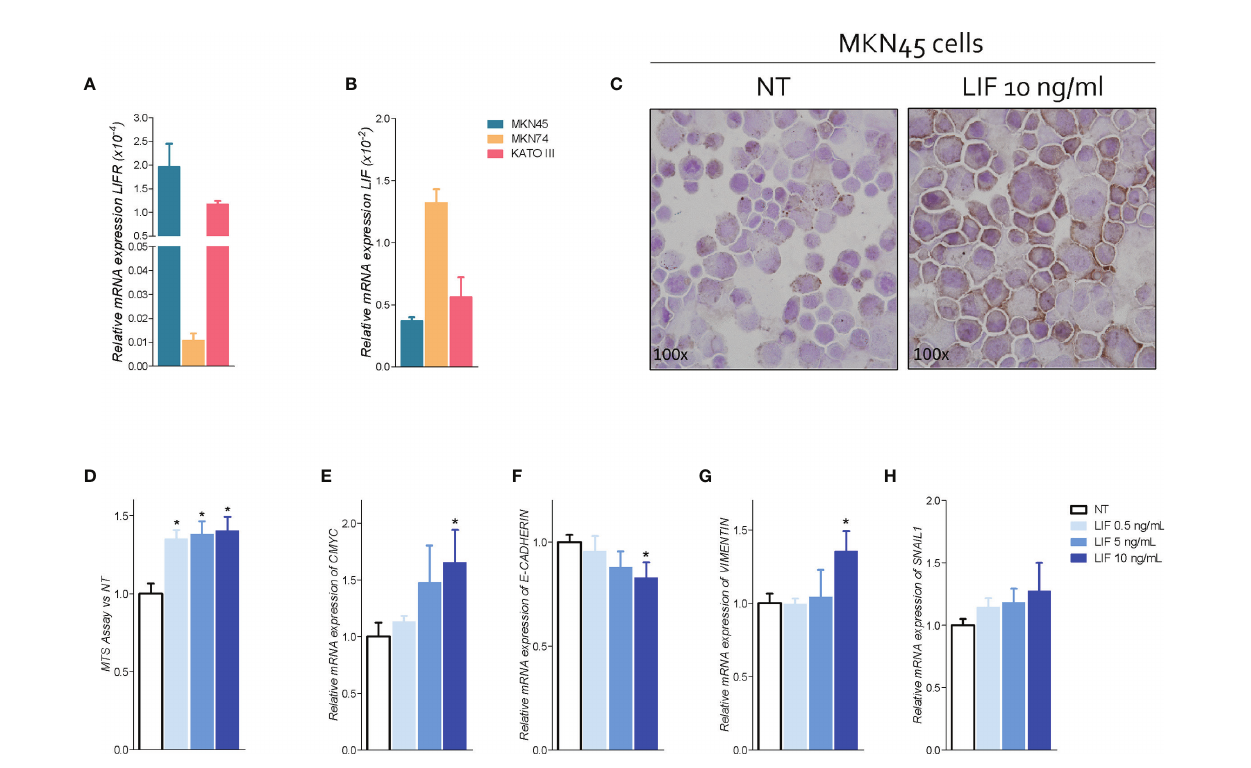
FIGURE 5 | LIFR activation promotes cell proliferation and EMT in MKN45 cells. Relative mRNA expression (A) LIFR and (B) LIF in CG cell lines. (C) IHC staining of LIFR in MNK45 cell lines on the left untreated and on the right triggered with LIF (10 ng/ml; magni fi cation, ×100). MKN45 cells were serum-starved and primed with LIF (0.5, 5, and 10 ng/ml). Data shown are as follows: (D) dose – response curve of LIF (0.5, 5, and 10 ng/ml) determined using MTS assay on MKN45 cells. Each value is expressed relative to those of non-treated (NT), which are arbitrarily settled to 1. Results are the mean±SEM of 10 samples per group. Relative mRNA expression of (E) the proliferation marker C-Myc and EMT markers (F) E-cadherin, (G) vimentin, and (H) Snal-1. Each value is normalized to Gapdh and is expressed relative to those of positive controls, which are arbitrarily settled to 1. Results are the mean±SEM of fi ve samples per group (* represents statistical signi fi cance versus NT, and # versus LIF,